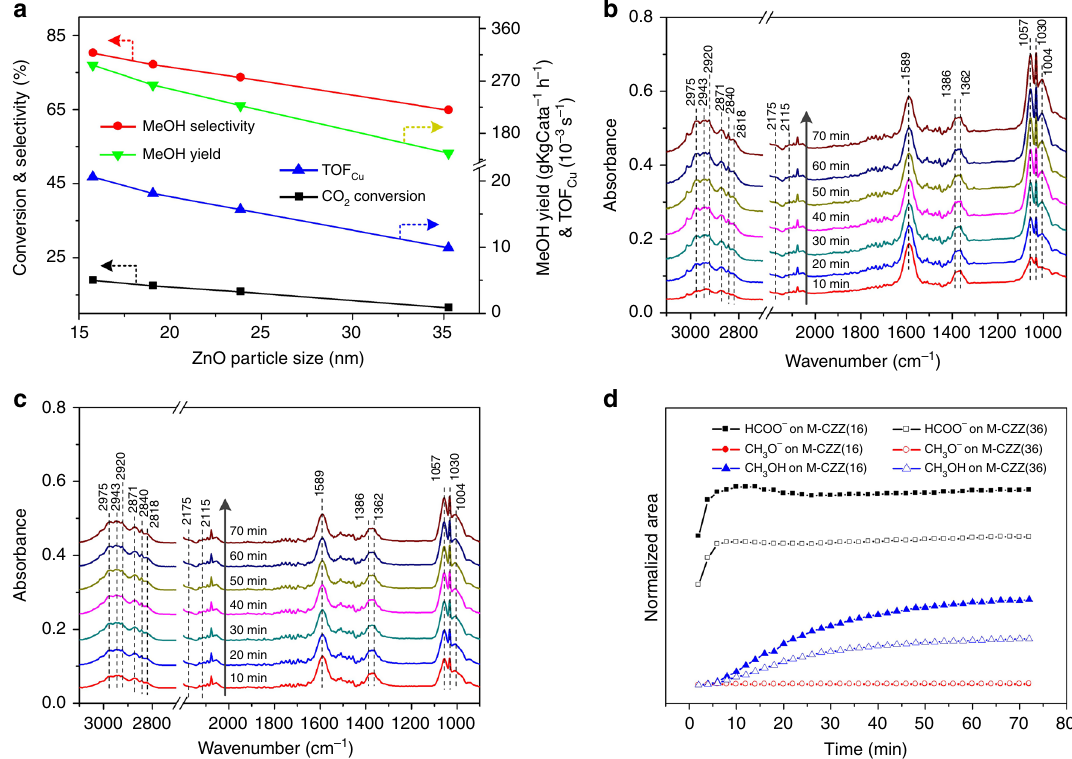
Fig. 2 Catalytic performance and in situ DRIFT spectra of the CO 2 + H 2 reaction over different catalysts. a CO 2 conversion, MeOH selectivity, MeOH yield and TOF values as a function of the ZnO particle sizes in different catalysts. b Evolution of the IR spectra over the M-CZZ(16) sample with time. c DRIFT spectra over the M-CZZ(36) sample. d Peak areas of generated intermediate species and methanol during the experiments: areas normalized to the values observed at the end of the transient. Reaction conditions for catalytic test: WHSV = 3 h − 1 , T = 493 K, CO 2 :H 2 = 1:3, P = 3.0 MPa; Reaction conditions for TOF calculation: WHSV = 10 h − 1 , T = 493 K, CO 2 :H 2 = 1:3, P = 3.0 MPa; Reaction conditions for in situ DRIFT spectra: gas fl ow rate = 40 mL/min, T = 493 K, CO 2 :H 2 = 1:3, P = 3.0 MPa. Formate species (2870, 1589, 1386, and 1362 cm − 1 ) and methanol (2975, 2943, 2920, 2871, 2840, and 2818 cm − 1 ) can be observed over the two samples, especially for the M-CZZ(16)